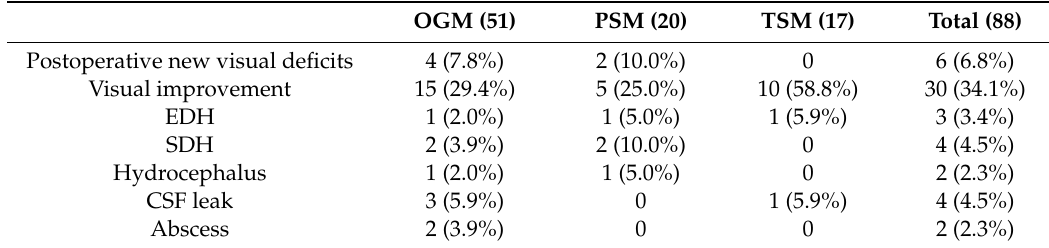
Table 3. Postoperative functional outcome and complications.